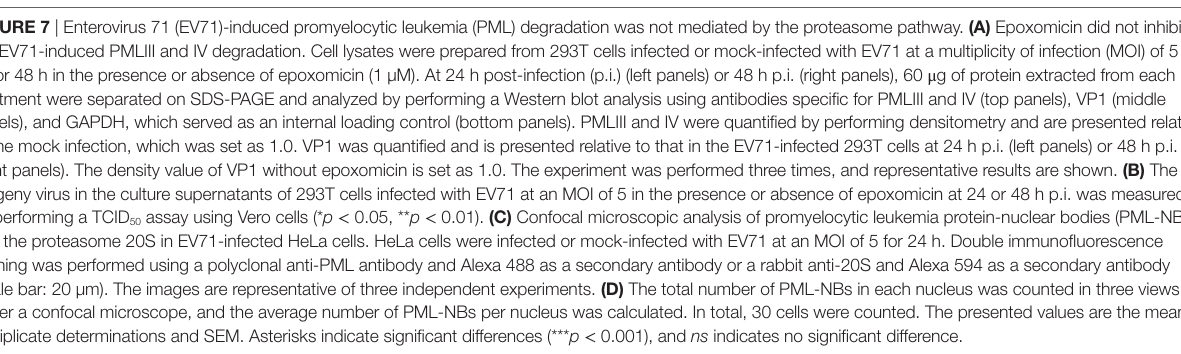
FigUre 7 | Enterovirus 71 (EV71)-induced promyelocytic leukemia (PML) degradation was not mediated by the proteasome pathway. (a) Epoxomicin did not inhibit the EV71-induced PMLIII and IV degradation. Cell lysates were prepared from 293T cells infected or mock-infected with EV71 at a multiplicity of infection (MOI) of 5 for 24 or 48 h in the presence or absence of epoxomicin (1 µM). At 24 h post-infection (p.i.) (left panels) or 48 h p.i. (right panels), 60 μ g of protein extracted from each treatment were separated on SDS-PAGE and analyzed by performing a Western blot analysis using antibodies specific for PMLIII and IV (top panels), VP1 (middle panels), and GAPDH, which served as an internal loading control (bottom panels). PMLIII and IV were quantified by performing densitometry and are presented relative to the mock infection, which was set as 1.0. VP1 was quantified and is presented relative to that in the EV71-infected 293T cells at 24 h p.i. (left panels) or 48 h p.i. (right panels). The density value of VP1 without epoxomicin is set as 1.0. The experiment was performed three times, and representative results are shown. (B) The progeny virus in the culture supernatants of 293T cells infected with EV71 at an MOI of 5 in the presence or absence of epoxomicin at 24 or 48 h p.i. was measured by performing a TCID 50 assay using Vero cells (* p < 0.05, ** p < 0.01). (c) Confocal microscopic analysis of promyelocytic leukemia protein-nuclear bodies (PML-NBs) and the proteasome 20S in EV71-infected HeLa cells. HeLa cells were infected or mock-infected with EV71 at an MOI of 5 for 24 h. Double immunofluorescence staining was performed using a polyclonal anti-PML antibody and Alexa 488 as a secondary antibody or a rabbit anti-20S and Alexa 594 as a secondary antibody (scale bar: 20 µm). The images are representative of three independent experiments. (D) The total number of PML-NBs in each nucleus was counted in three views under a confocal microscope, and the average number of PML-NBs per nucleus was calculated. In total, 30 cells were counted. The presented values are the means of triplicate determinations and SEM. Asterisks indicate significant differences (*** p < 0.001), and ns indicates no significant